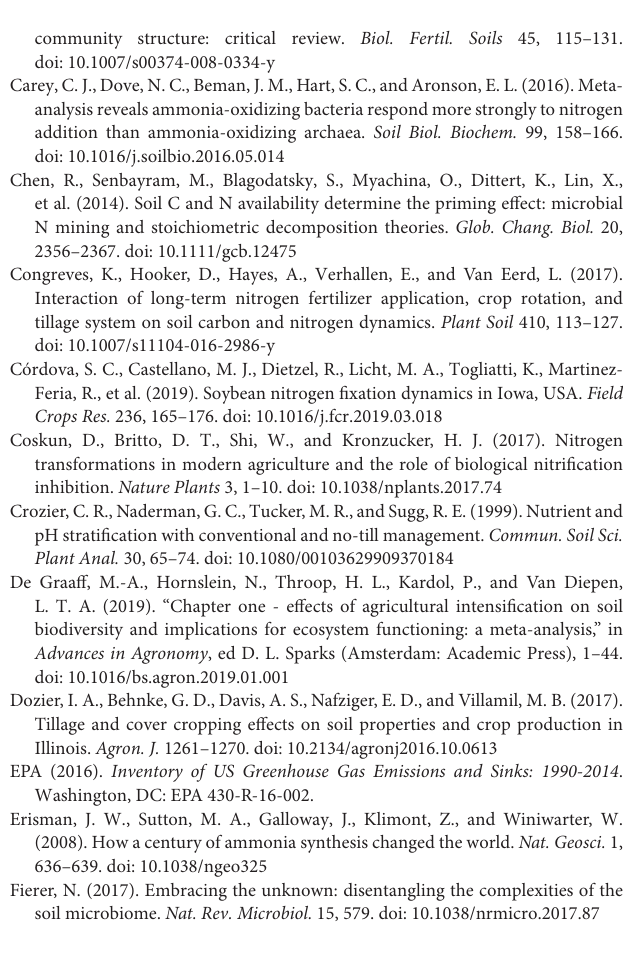
Supplementary Figure S1 | Top panel: Monthly precipitation (mm) totals for 2019 (red) and the historical average (1989-2019, black). Error bars for the historical average represent standard errors of the 30-year mean. Bottom panel: Monthly temperature averages ( ◦ C) for 2019 (red) and the historical average (1989-2019, black). Error bars above each main bar represent standard errors of the